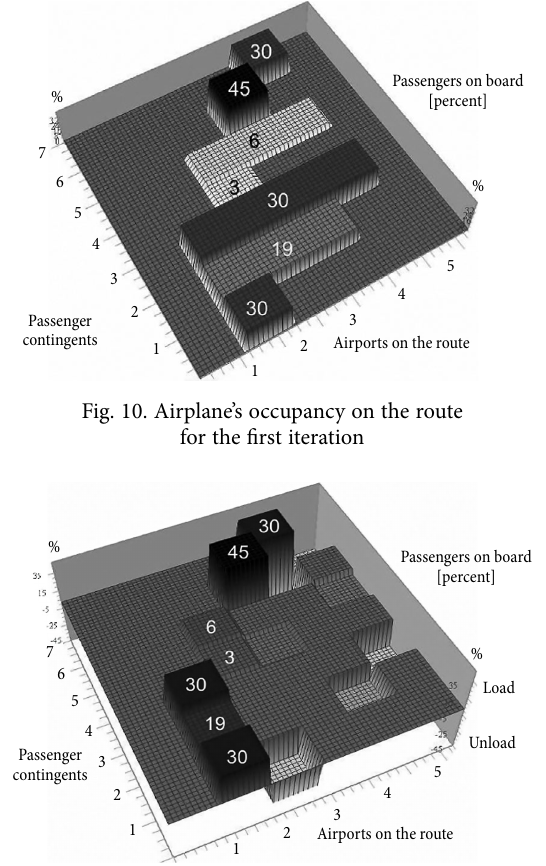
Fig. 11. Loads and unloads in particular airport